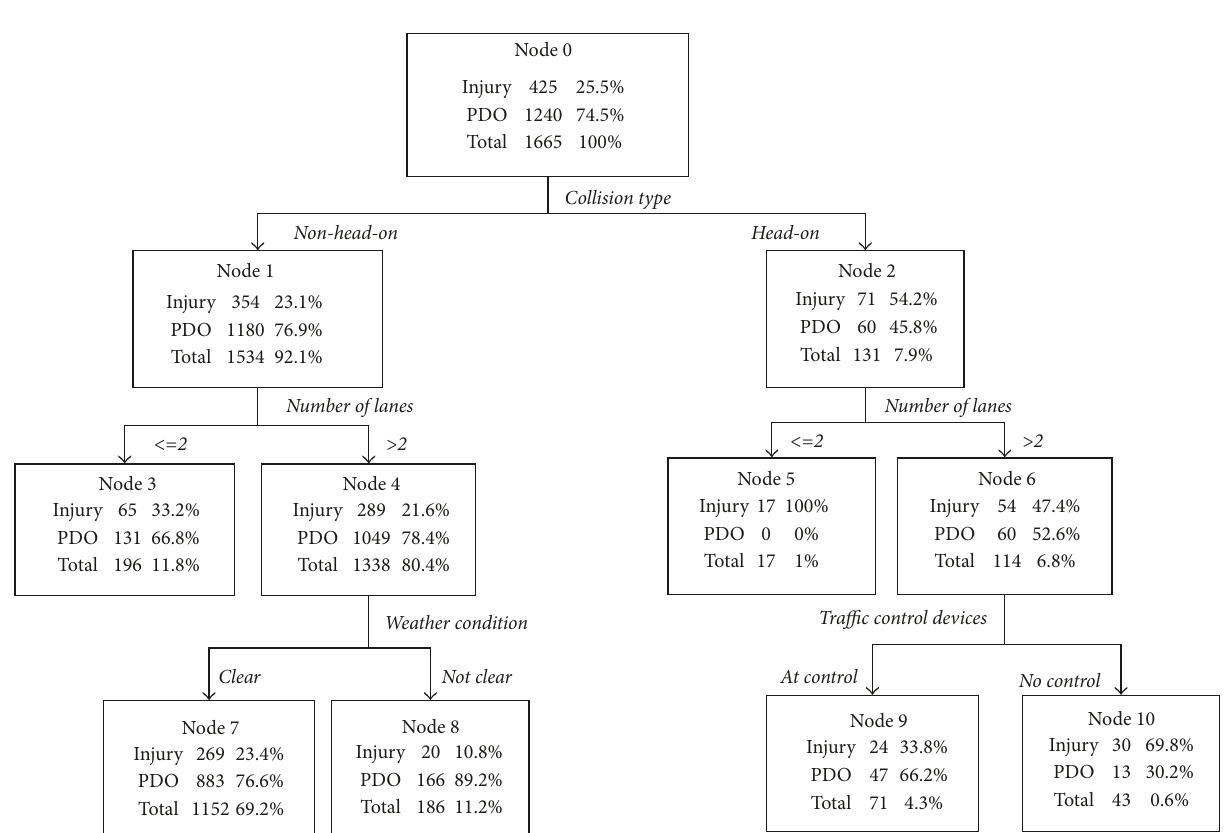
Figure 3: Decision tree under dark-lighted condition.